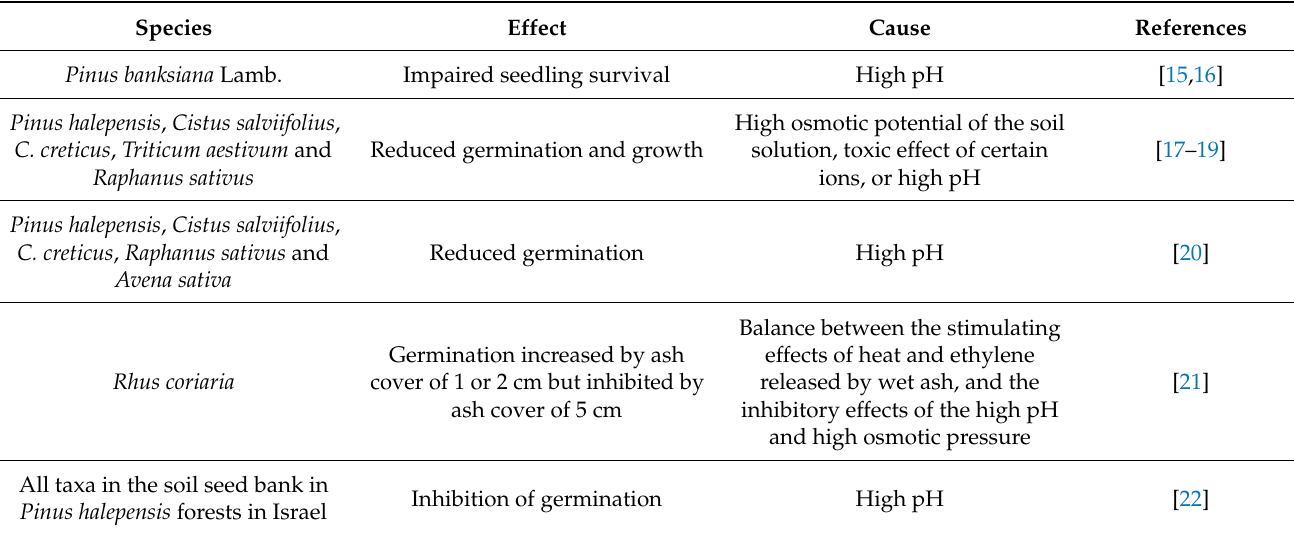
Table 1. Effects of ash or burning on plant